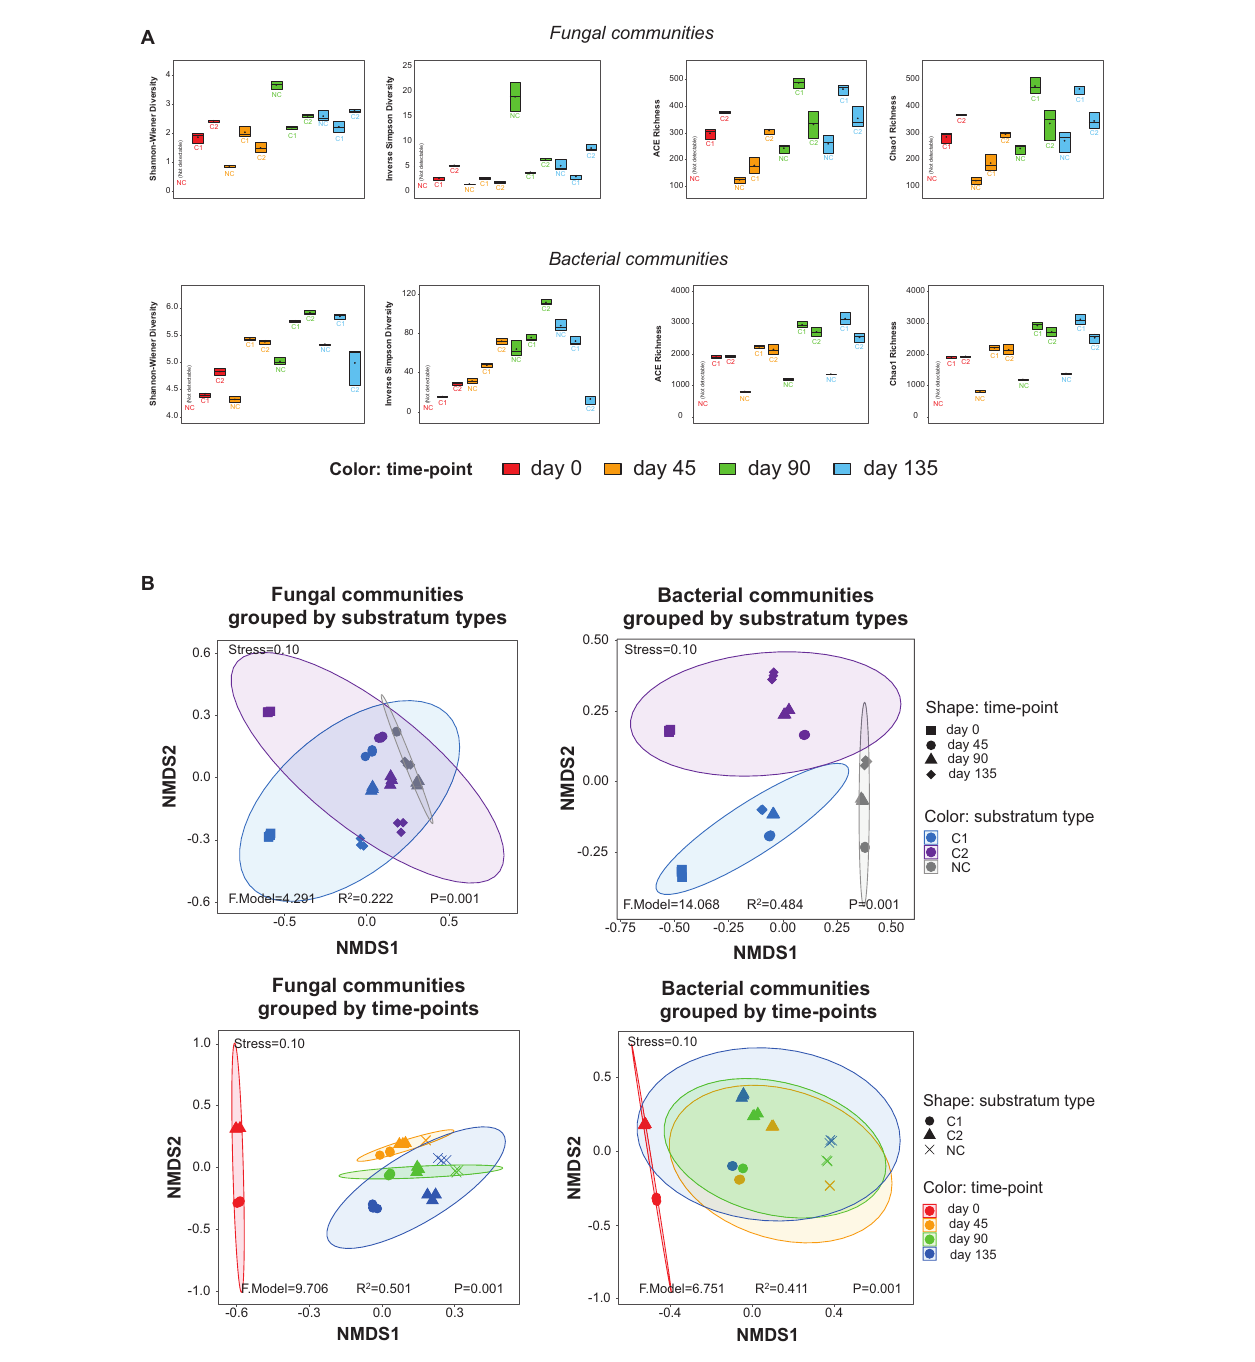
FIGURE 2 | (A) α -diversity estimators of the fungal and bacterial communities, shown by boxplots. The values of the estimators are provided in the online Supplementary Materials as Supplementary Table 4 . (B) Impacts of substratum type and time-point on the grouping of the fungal and bacterial communities, shown by NMDS plots based on the β -diversity of the samples.